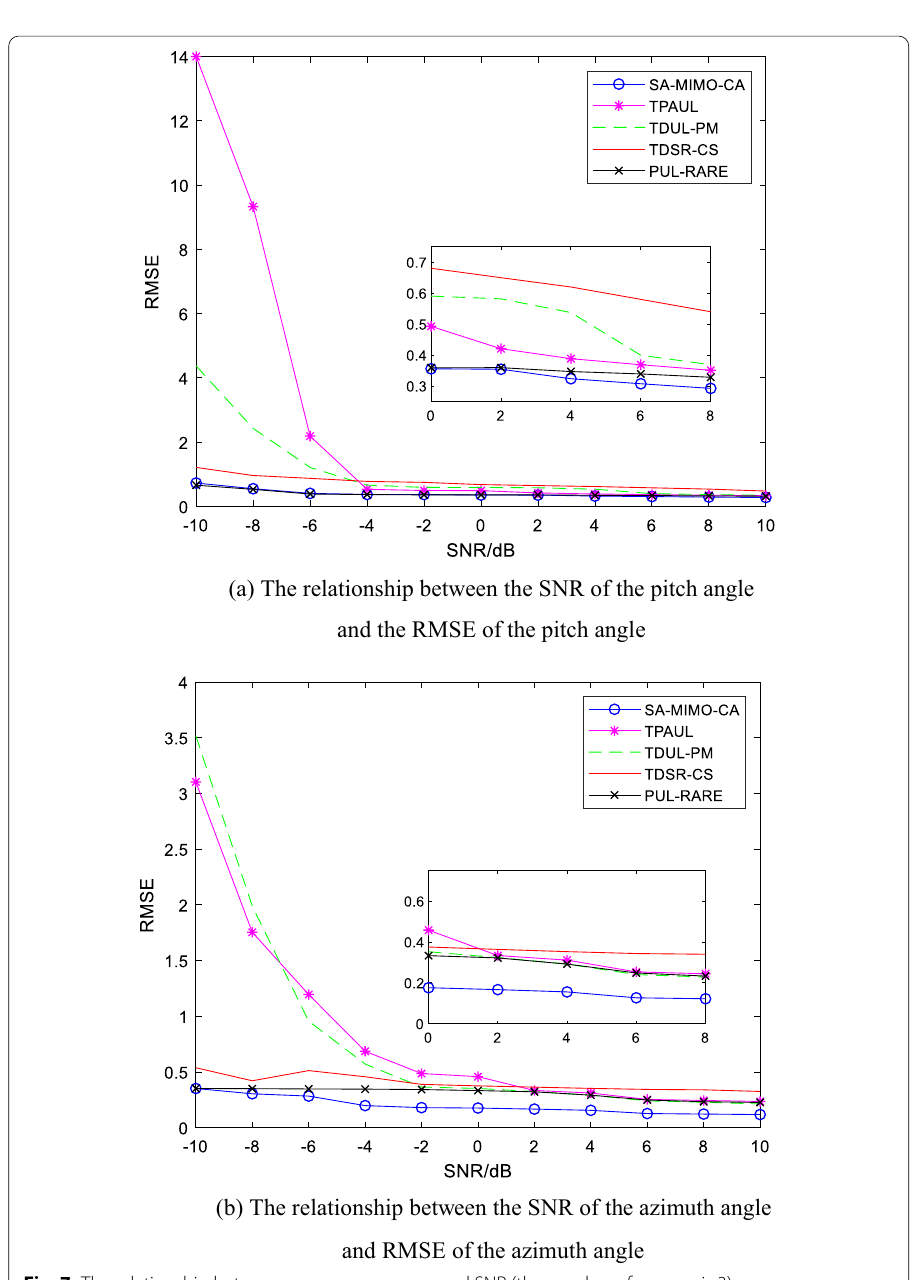
Fig. 7 The relationship between mean square error and SNR (the number of sources is 3)